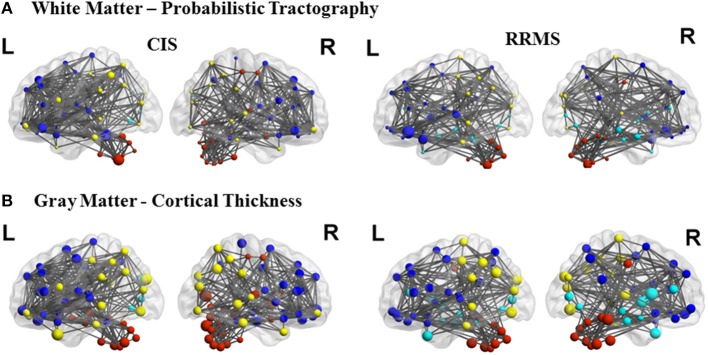
Topological representation of the parameter clustering coefficient (size of the nodes), structural connections (links), and modules (color of the nodes) for CIS and RRMS. Left (L) and right (R) hemispheres are shown. The first row shows the white matter connectivity derived from DTI and probabilistic tractography and the second row from the cortical thickness correlation analysis.